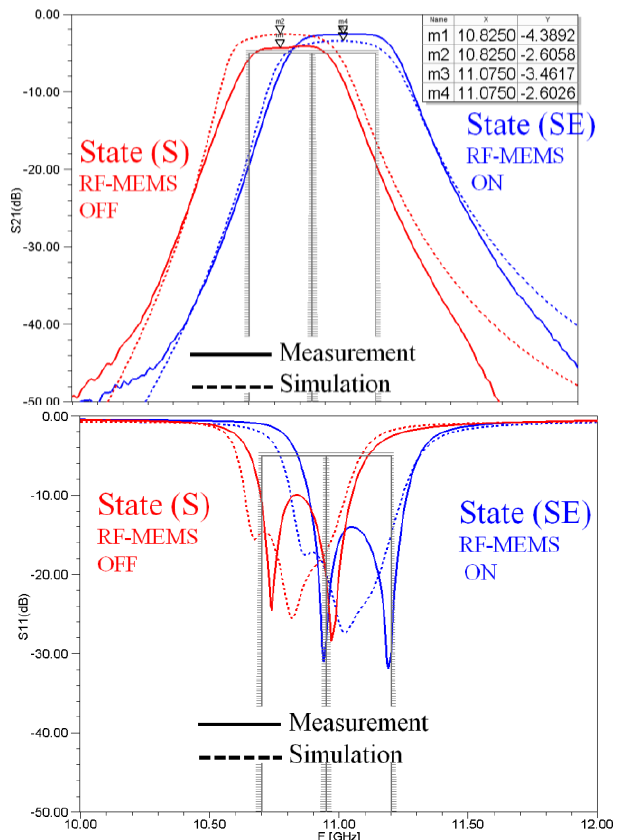
Figure 8. High-frequency structure simulation (HFSS) and measured S-parameters (S21 top and S11 down) of the tunable filter.